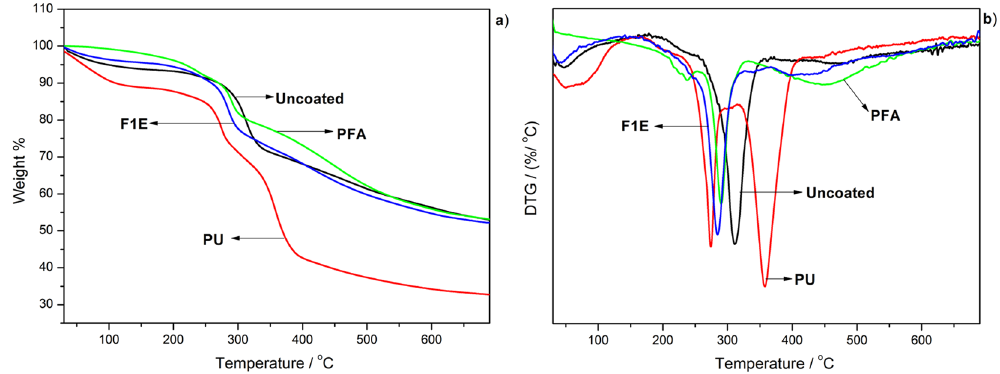
Figure 4. ( a ) TGA and ( b ) DTG curves of phenolic/flax fibre laminates after environmental